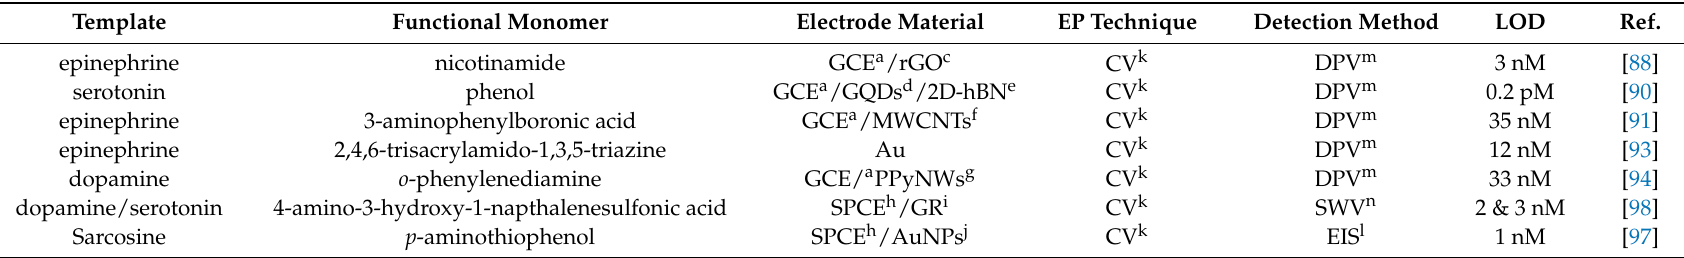
Table 2. Summary of recent publications for the detection of neurotransmitters using eMIPs. Includes information on the functional monomer used, electrode material, polymerization technique, detection method, and Limit Of Detection